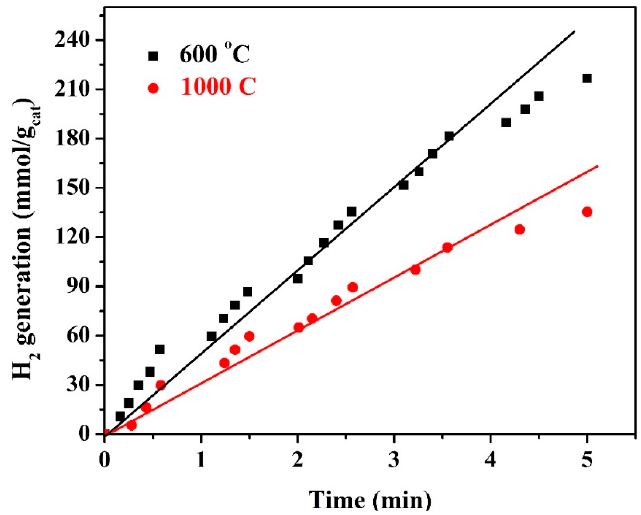
Figure 14. Influence of the calcination temperature on the hydrogen production rate from water splitting under visible light radiation; KOH concentration of 1.0 M, hydrothermal time of 3 h, and hydrothermal temperature of 170 °C.